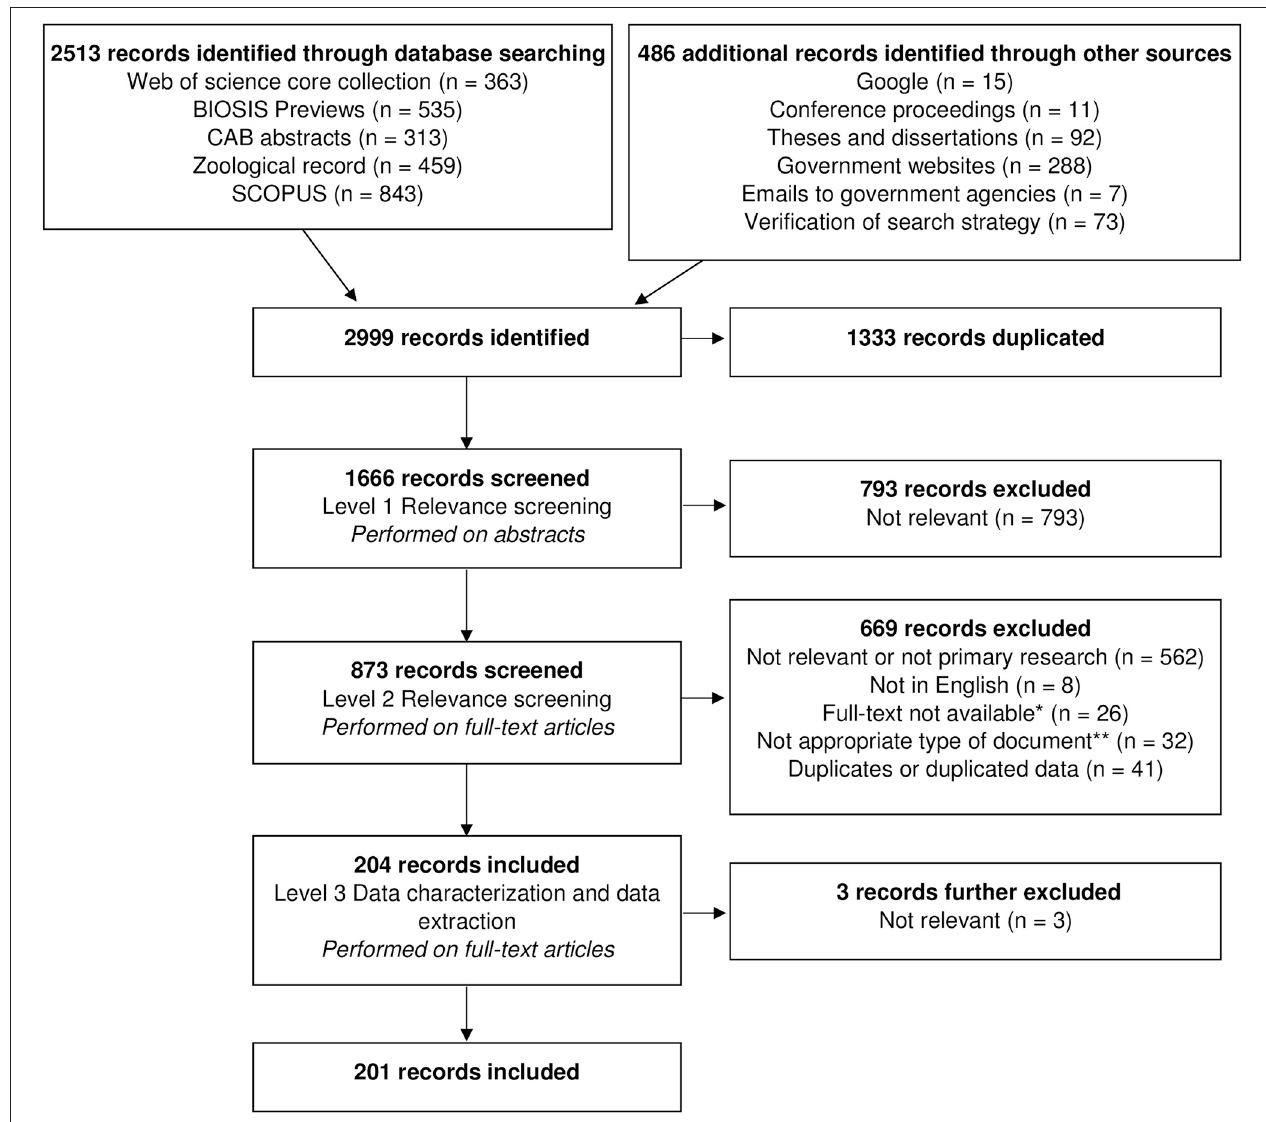
FIGURE 1 | Flow chart of a scoping review focused on the ecology and biology of dingoes, feral domestic dogs, and dingo-dog hybrids in Australia, targeting 28 specific topics of interest selected to inform disease spread models. *Twelve of these records were captured from the “Verification of search strategy.” **Includes 15 progress reports or annual reports from government or research